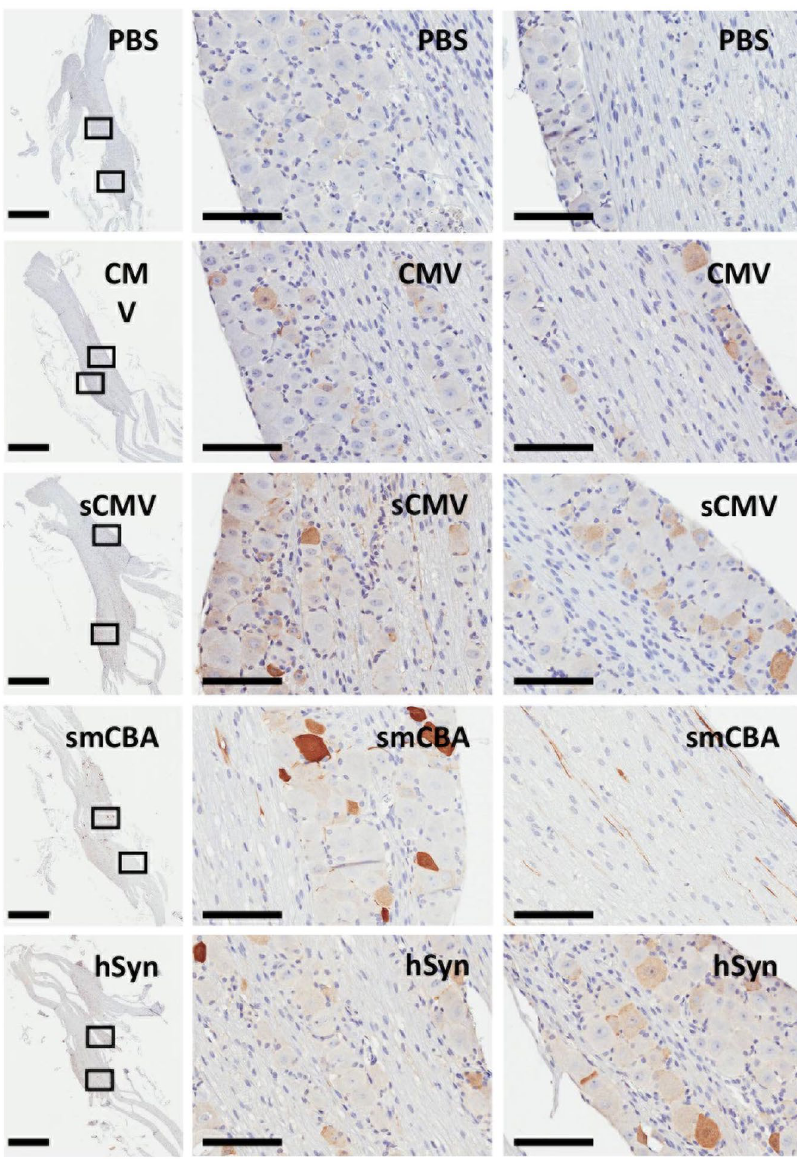
Figure 3. Comparison of constitutive and neuronal-specific promoters for gene expression in trigeminal ganglia. Swiss Webster mice were inoculated by intradermal injection of the whiskerpad with PBS or 1 × 10 11 vector genomes of scAAV1-CMV-GFP, scAAV1-sCMV-GFP, scAAV1-smCBA-GFP or scAAV1-hSyn- GFP. Sections from trigeminal ganglia harvested at 14 days post AAV delivery were stained for GFP by immunohistochemistry. Scale bar: left panel - 1 mm, right two panels - 100 μ